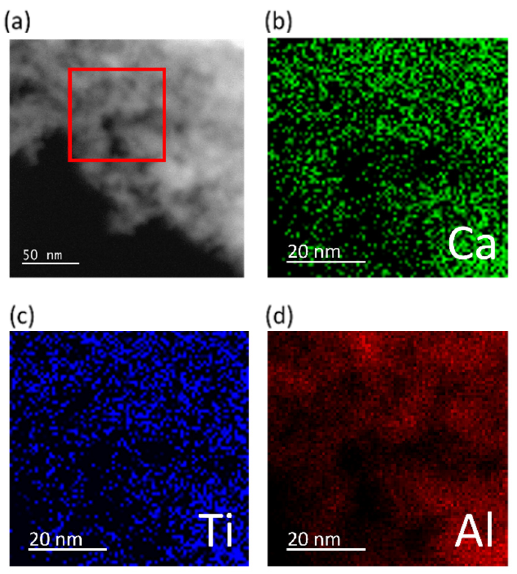
Figure 2. ( a ) High angle annular dark field (HAADF) STEM image of the 18 wt% CaTiO 3 /Al 2 O 3 sample; ( b – d ) are EDS maps of Ca, Ti and Al, taken from the region indicated by the red frame.